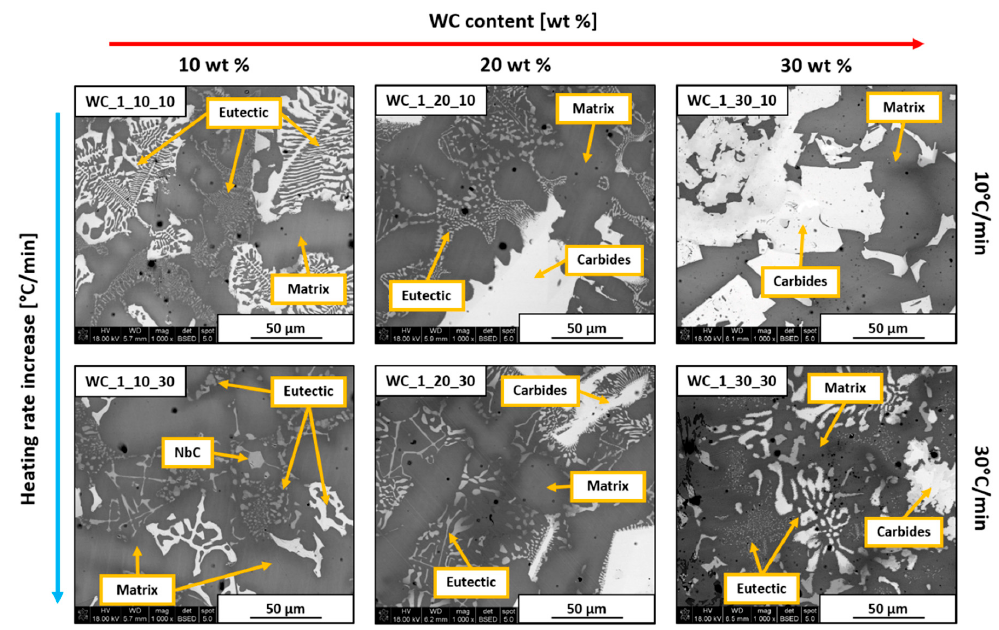
Figure 5. SEM images of Inconel 625–WC_1 sample cross-sections.